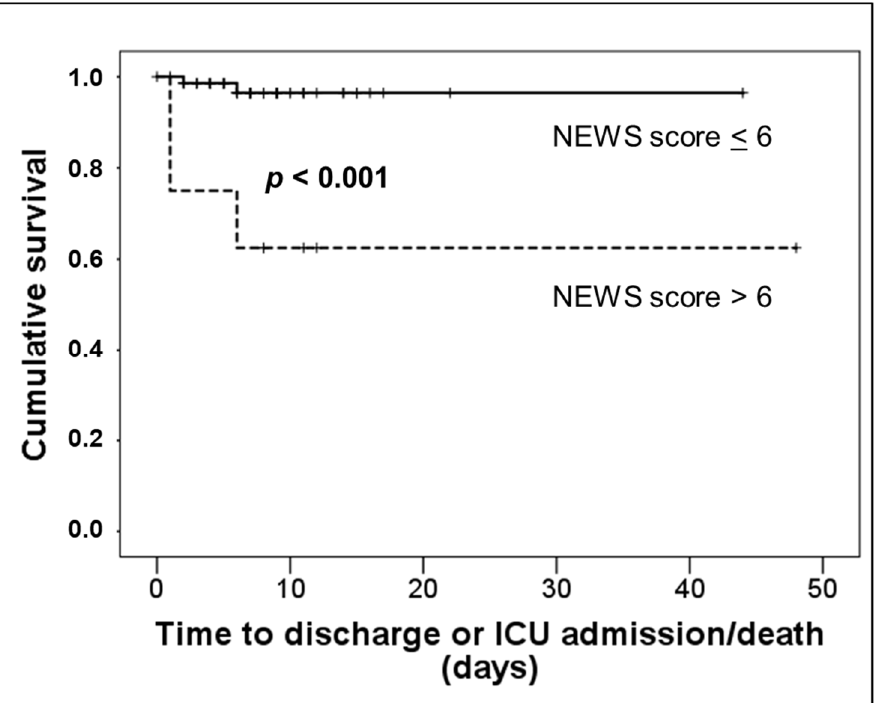
Figure 3. Kaplan–Meier survival curves of patients with pneumonia by SARS-CoV-2 as a function of a NEWS2 score ≤ 6 (continuous line) or > 6 (dashed line). Table 4. Outcomes in surviving patients with pneumonia by SARS-CoV-2 ( n =